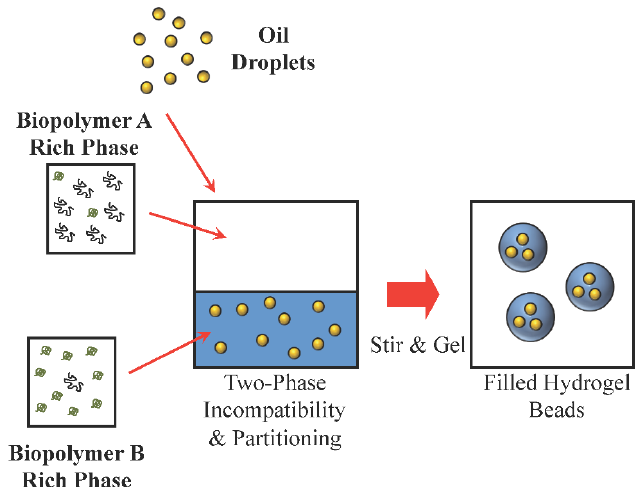
Figure 6. Schematic representation of production of the encapsulation of oil droplets in hydrogel particles formed by thermodynamic incompatibility method. An oil-in-water-in-water (O/W/W) emulsion may form when lipid droplets and two biopolymers are mixed together under conditions where phase separation occurs.